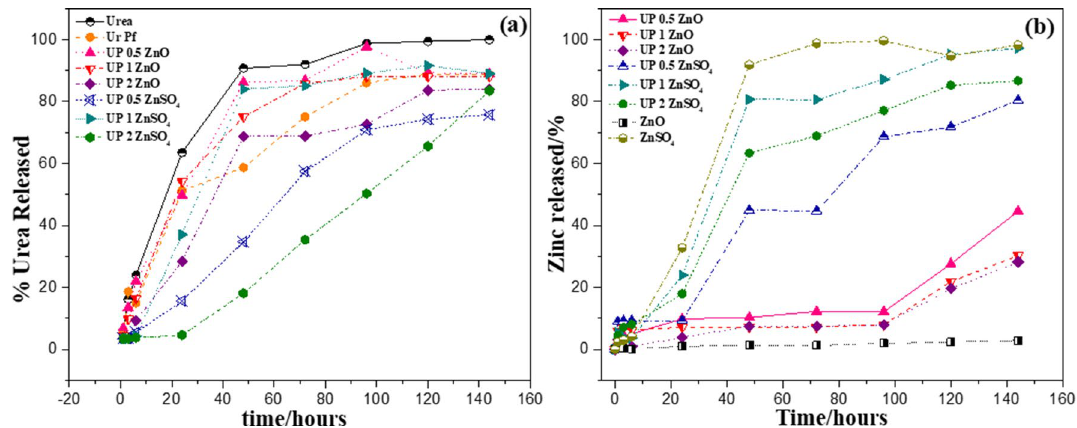
Figure 7. Release rates for ( a ) urea species and ( b ) zinc of materials cultivated in still